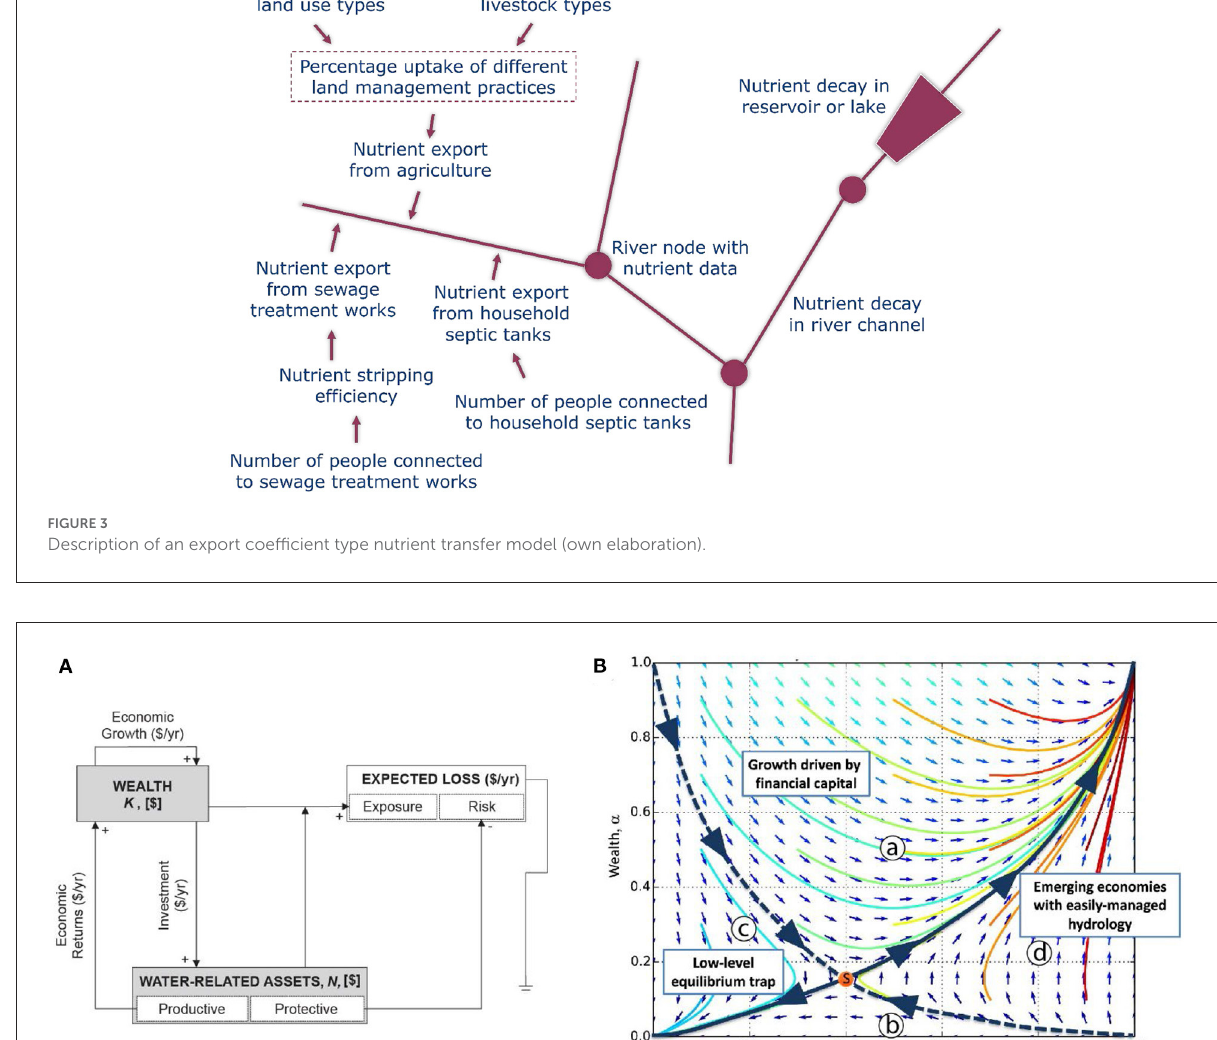
“natural, hydrological endowment” (Dadson et al., 2017: 6426) 4 .